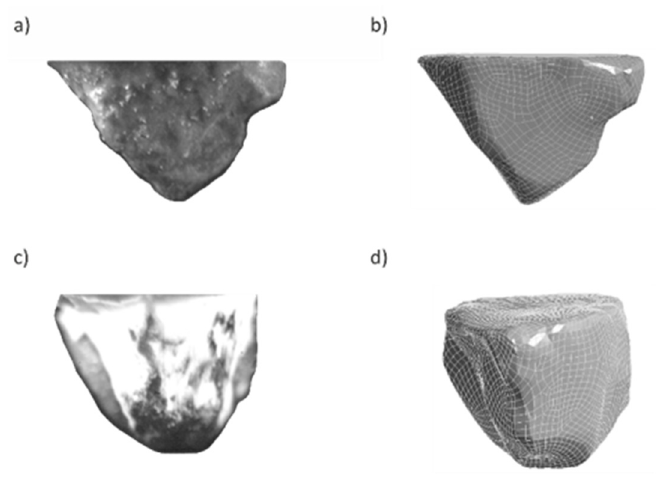
Figure 3. The geometries of the abrasive grains used in the tests: ( a ) grain macrophotography of ZS1, ( b ) geometric model of grain ZS1, ( c ) macrophotography of grain ZS2, ( d ) geometric model of grain ZS2.